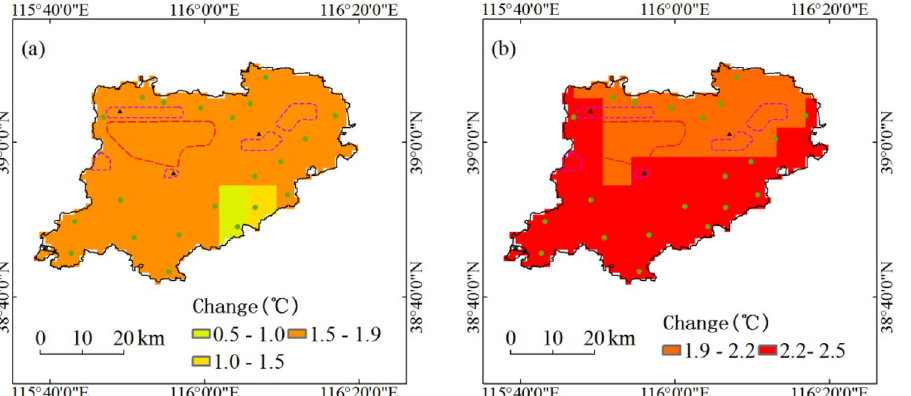
Figure 4. Projected changes of annual maximum temperature with five return periods during the period 1991–2050. Maps show return periods of 10-year, 20-year, 30-year, 50-year and 100-year under RCP4.5 scenario ( a ) and under RCP8.5 scenario ( b ). Maps generated in ArcGIS